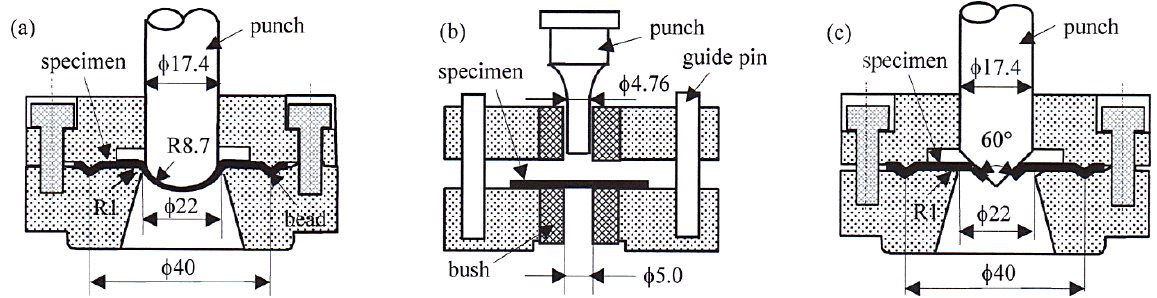
Figure 2. Die dimensions for ( a ) stretch-forming, ( b ) hole-punching and ( c ) hole-expanding tests.